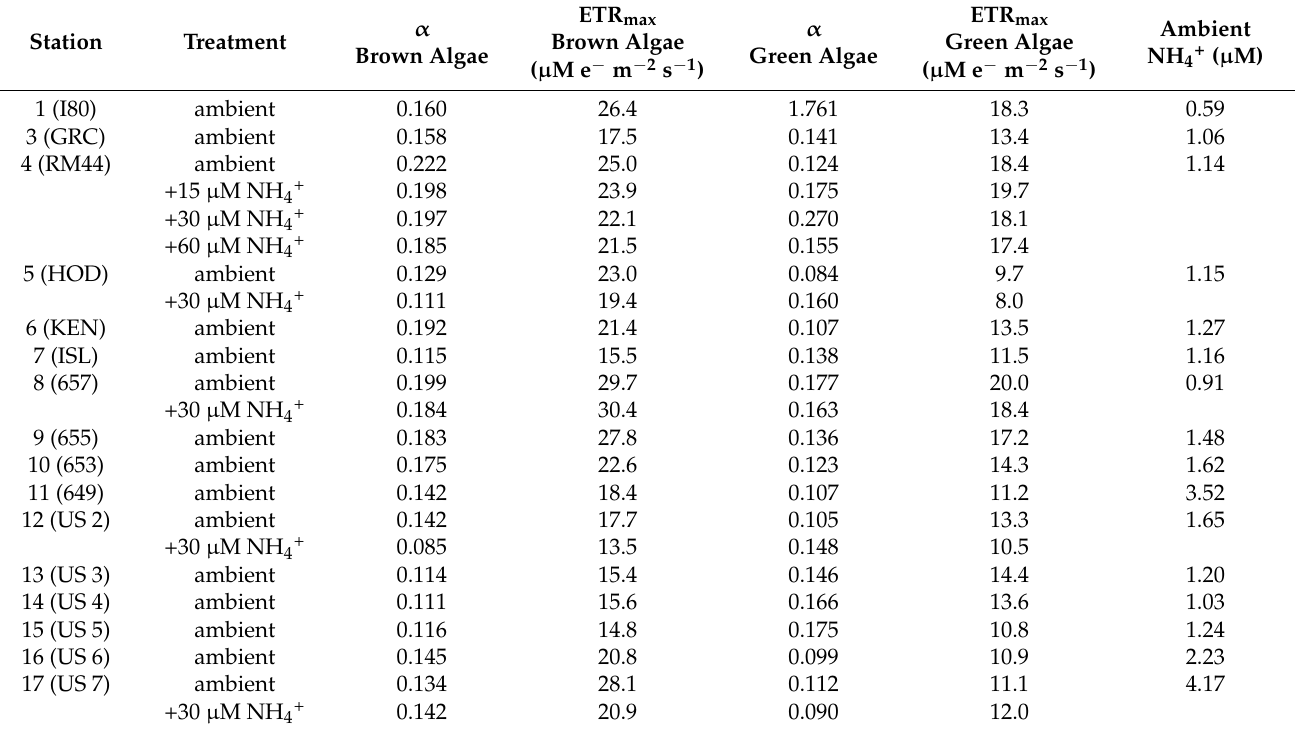
Table 3. Parameters from Rapid Light Curves measured at stations and under conditions indicated. Ambient samples were dark adapted for 20 min. NH 4+ enriched samples were measured approxi- mately 6 h after enrichment and a 20 min dark acclimation. Algal groups were differentiated by the PhytoPAM II. Ambient concentrations of NH 4+ are listed for